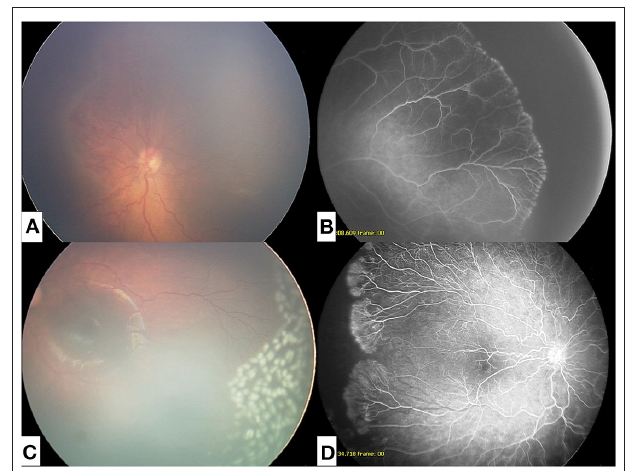
FIGURE 1 | (A) Fundus photograph at time of diagnosis of APROP. (B) Fluorescein angiogram of APROP demonstrating peripheral non-perfusion. (C) Fundus photograph of regressed APROP following intravitreal injection with bevacizumab and modified peripheral photocoagulation. (D) Fluorescein angiogram of reactivated APROP following intravitreal